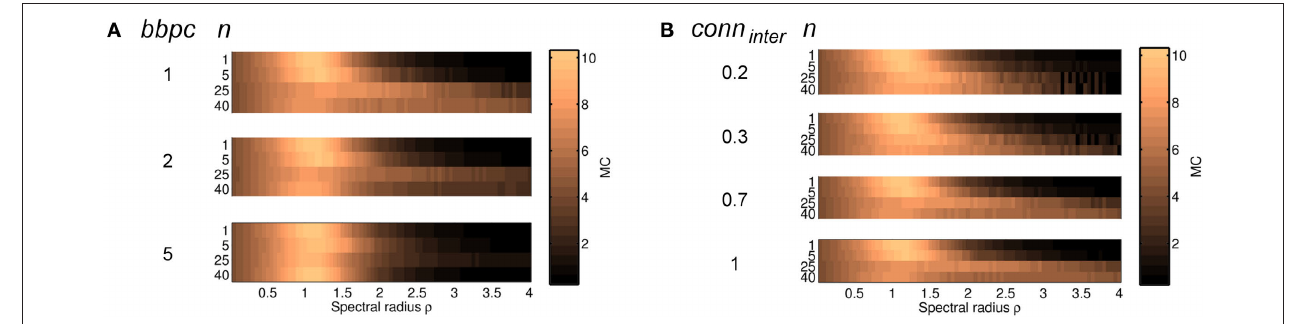
Figure 9 | MC was calculated for four different cluster configurations as r was increased from 0.05 to 4 ( R = 200, conn bbpc = 1, unless otherwise stated). The effect of increasing bbpc (A) and varying conn over a broader range of r